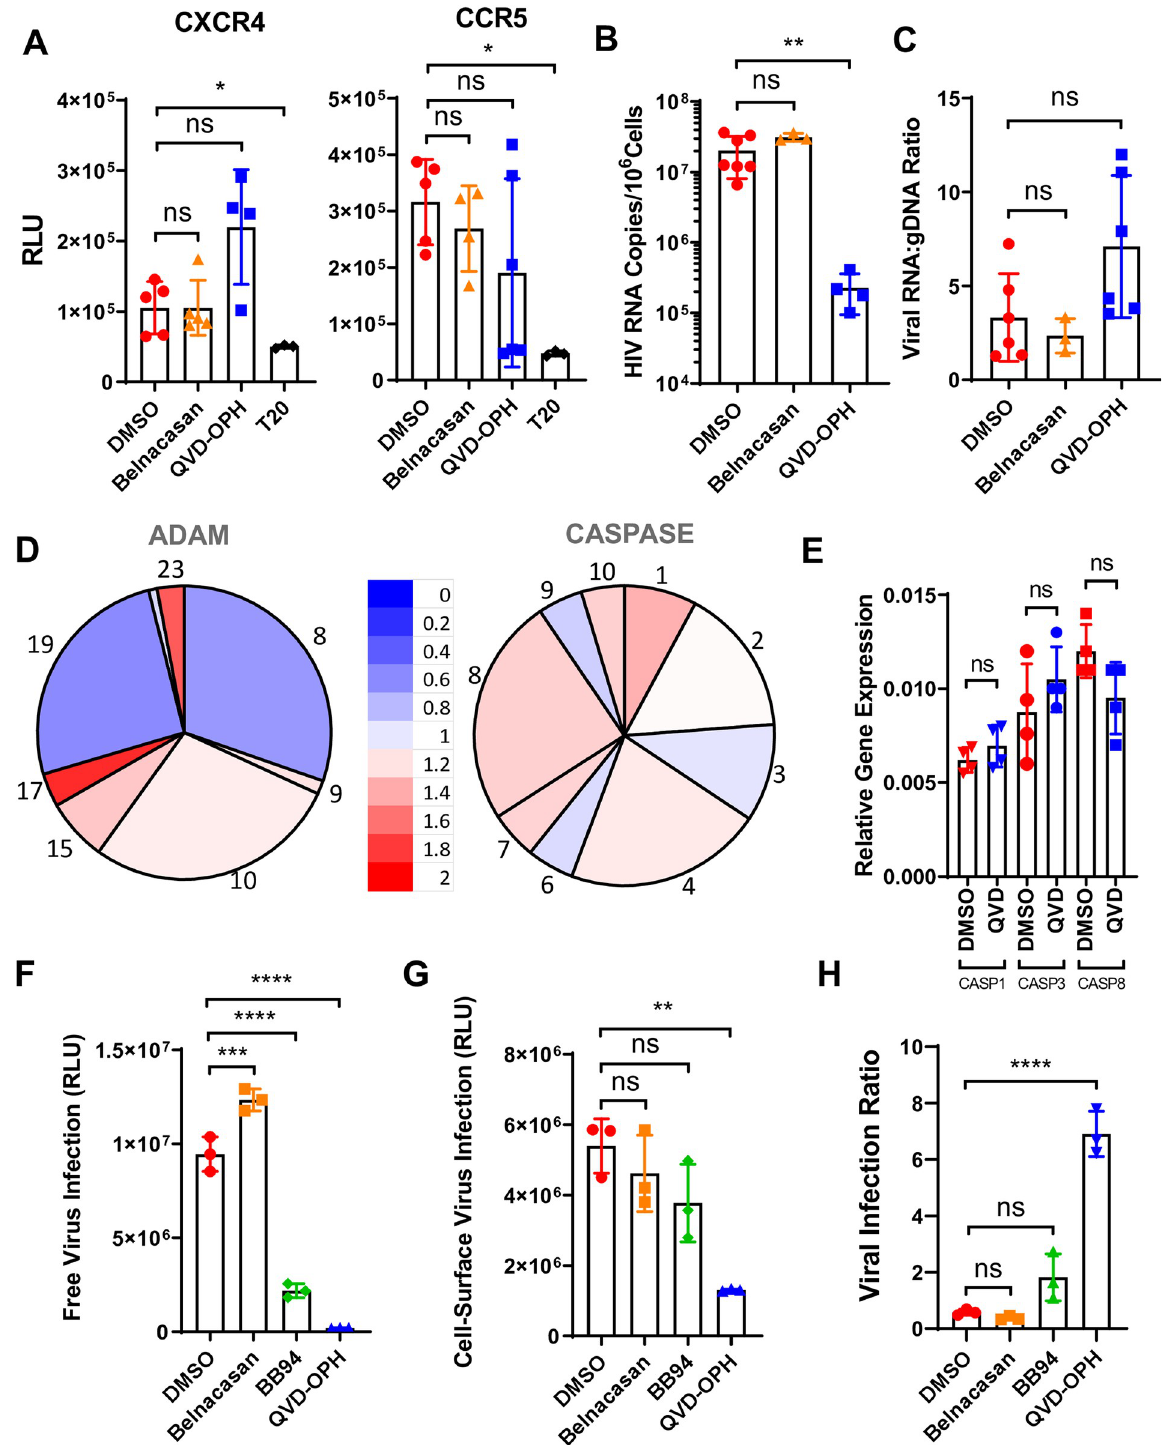
Fig 4. Caspase inhibition reduced HIV viral release. (A) Infections of replication-incompetent JRFL (CCR5-tropic) and SF33 (CXCR4-tropic) luciferase-expressing pseudo-HIV to PBMC in the presence of caspases inhibitors, Belnacasan (orange), QVD-OPH (blue), HIV-1 entry inhibitor, T20 (black), or control DMSO (red). The levels of infections are measured by luciferase activities in relative light units. Statistical analyses are performed using Mann-Whitney nonparametric test � p < 0.05. (B) Total HIV RNA per 10 6 cells was determined by RT-PCR of day 6 HIV-1 BAL infected primary CD4 T cells in the presence of Belnacasan, QVD-OPH or control DMSO. Significant reduction of total HIV RNA